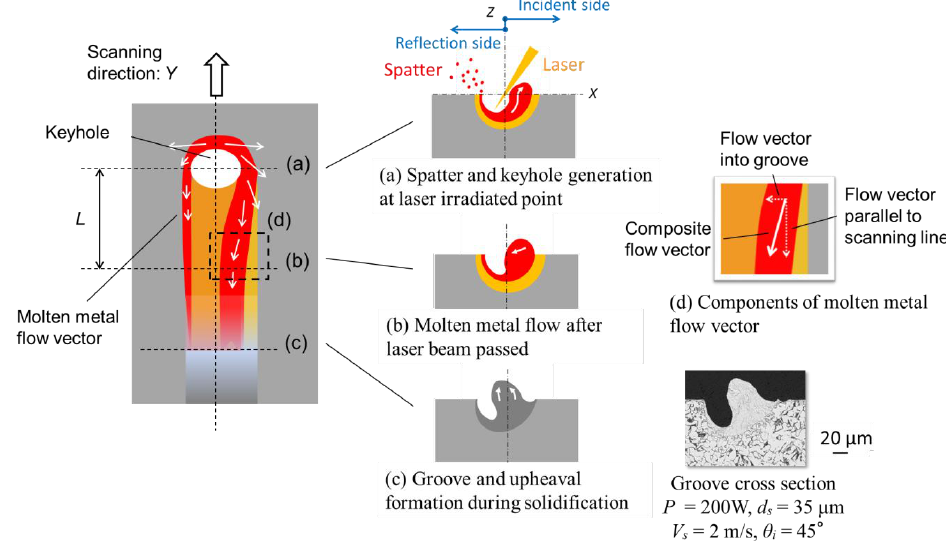
Figure 9. Schematic illustration of molten metal behavior under angled laser irradiation during high- speed scanning (mild